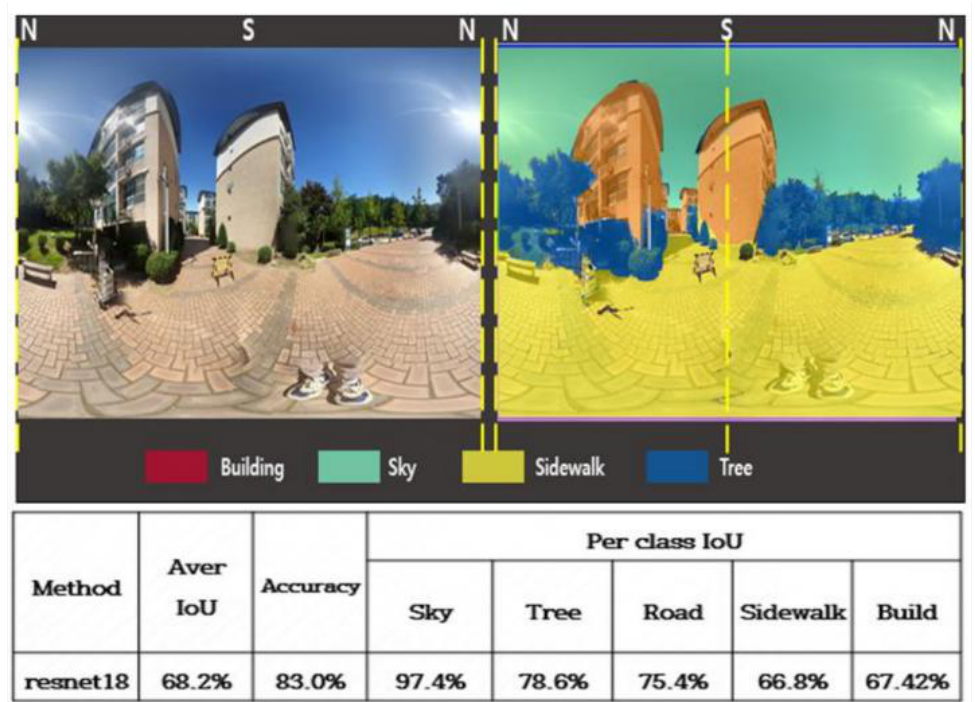
Figure A1. Workflow procedure for image segmentation to calculate VF using deep learning. ResNet 18 converged faster than other methods and was comparably accurate